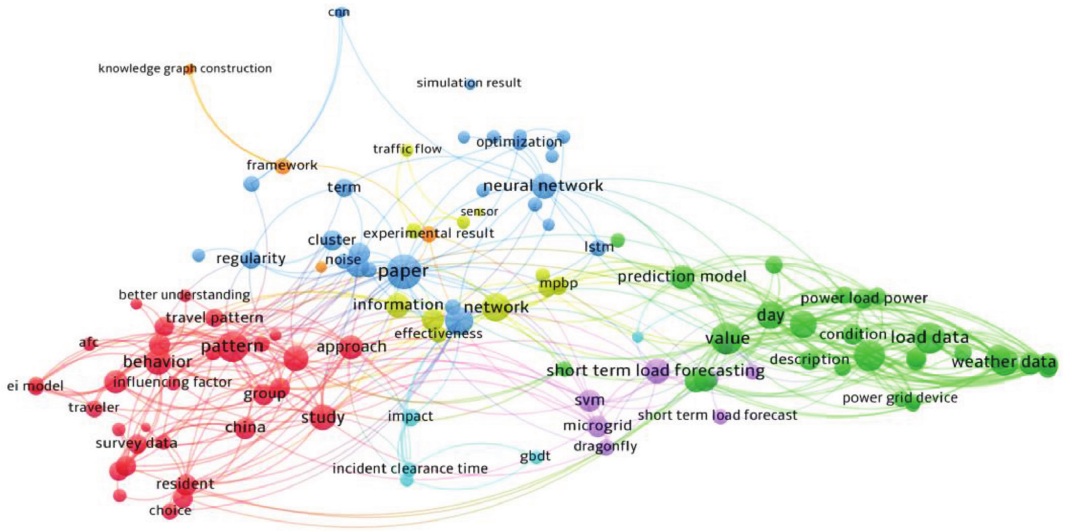
Figure 1: Keyword structure relationship of the related